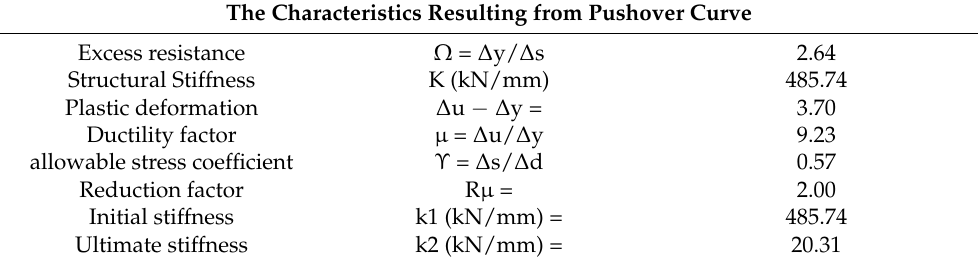
Table 4. The characteristics resulting from pushover curve.